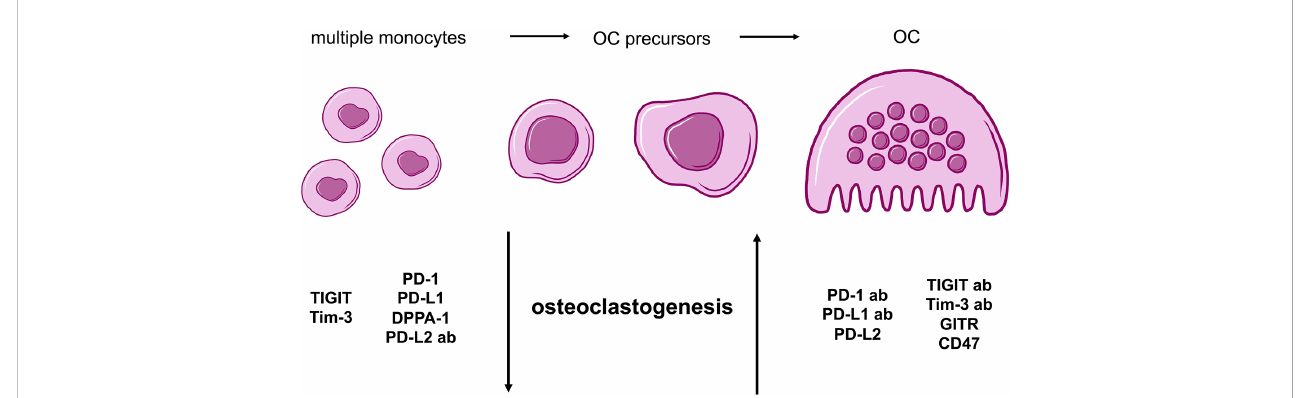
FIGURE 5 Summarizing cartoon of effects caused by agonistic and antagonistic targeting of immune checkpoint molecules during osteoclastogenesis. OC differentiation begins with multiple PBMCs that evolve into OC precursors and fi nally, mature OCs. For our study, two general groups of checkpoints can be distinguished based on characteristic alterations of osteoclastogenesis. Molecules with negative effect on osteoclastogenesis and therefore, a higher number of monocytes and OC precursors, are TIGIT, Tim-3, PD-1, PD-L1 proteins as well as DPPA-1 and PD-L2 antibody. In contrast, PD-1, PD-L1, TIGIT and Tim-3 antibodies as well as PD-L2, GITR and CD47 proteins present stimulation of OC